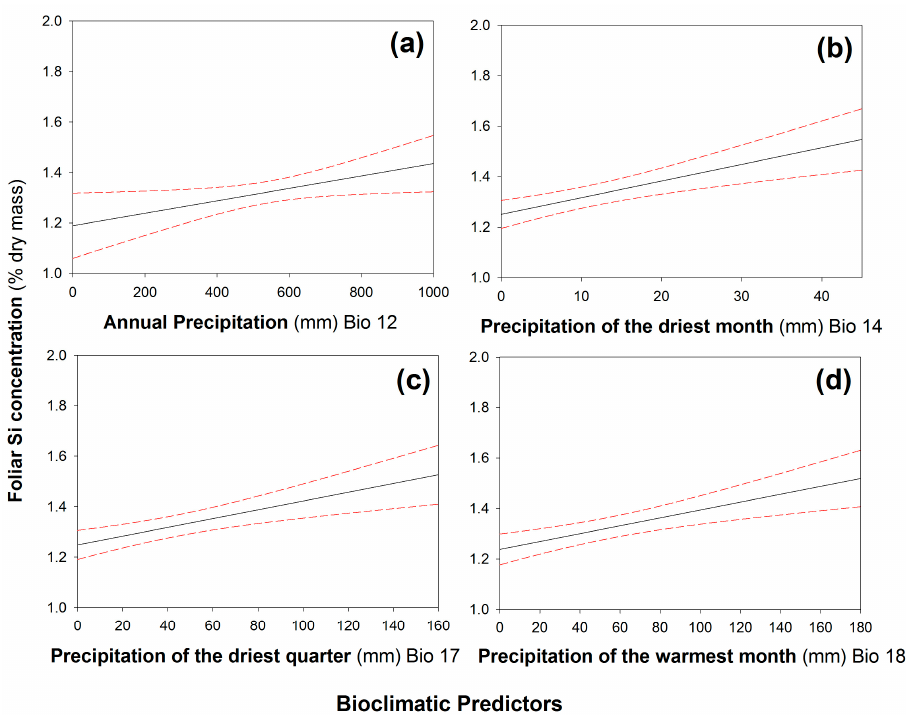
Figure 3. Significant positive correlations between leaf Si concentrations and ( a ) annual precipitation, ( b ) precipitation of the driest month, ( c ) precipitation of the driest quarter, and ( d ) precipitation of the warmest month. N = 247. Regression line (solid line) fitted with 95% confidence displayed as dashed lines. See Table 1 for statistical analysis.